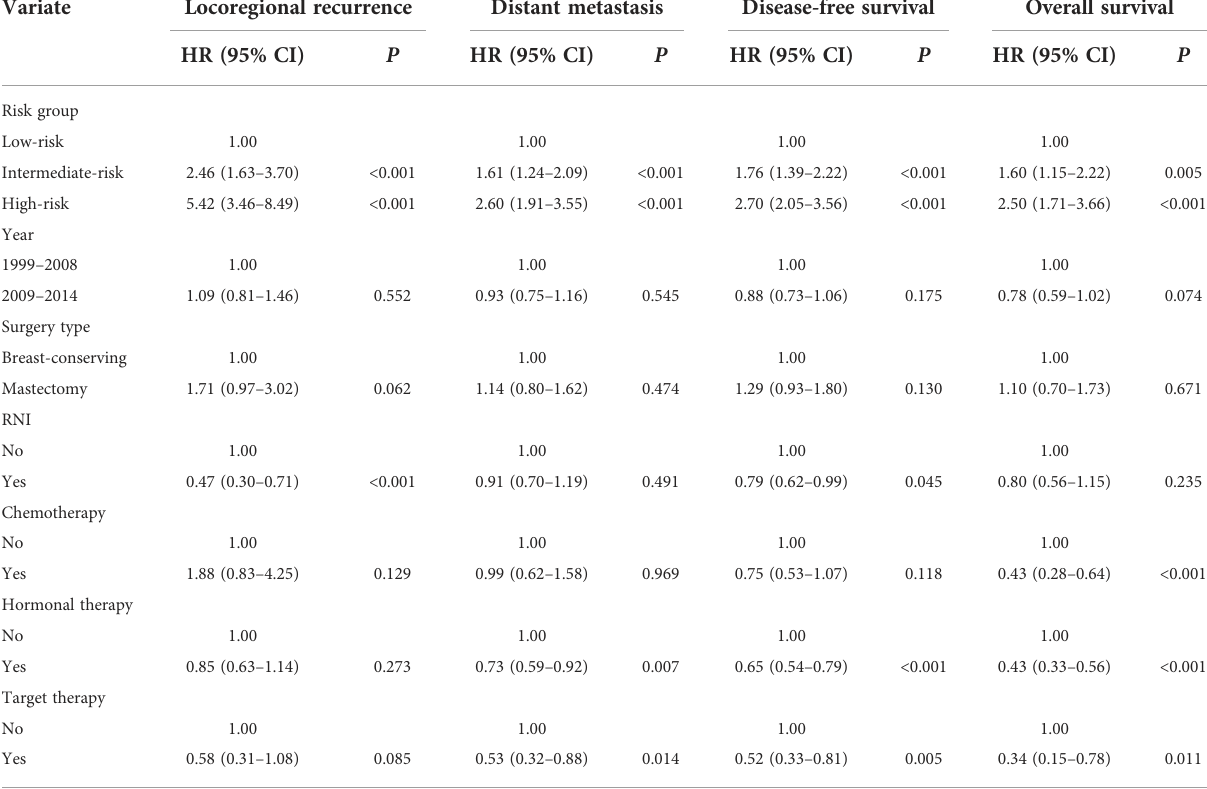
TABLE 3 Multivariate analyses of risk group adjusted by era and treatments.